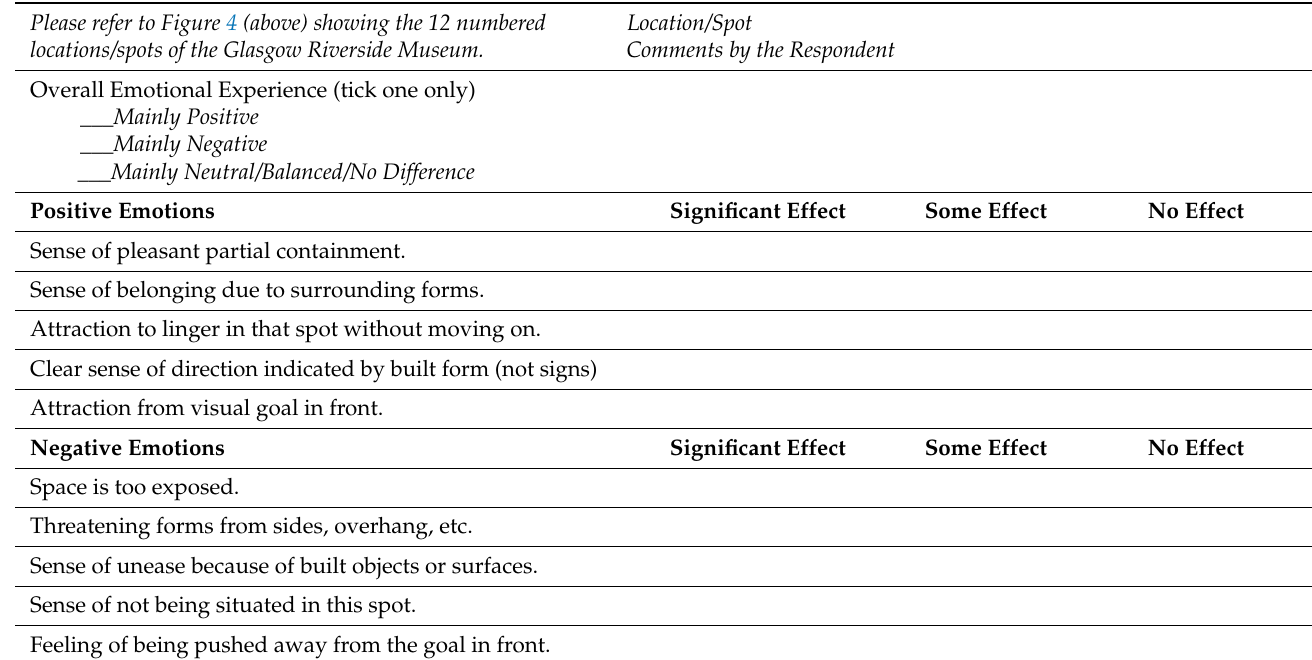
Table 2. Example of users’ emotional experience record